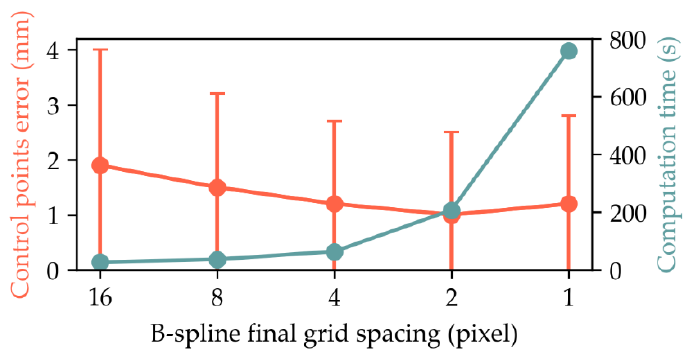
Figure 11. Effect of B-SPLINE final grid spacing on control points error and average computation time of twelve 900 nm images of wheat canopy acquired at six different dates before ears emer- gence.